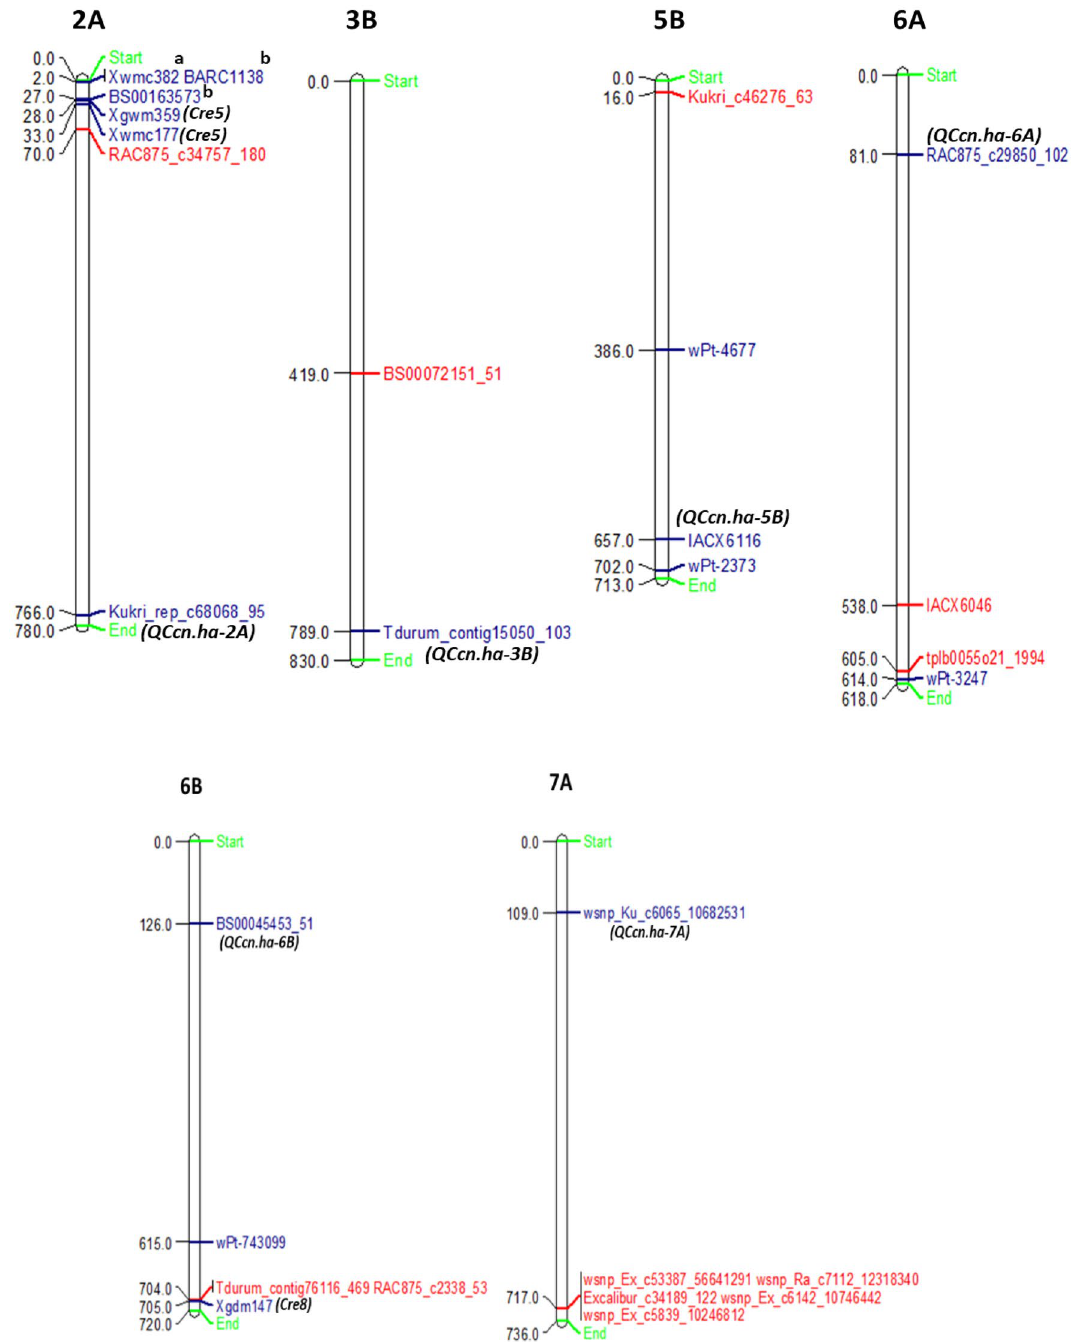
Figure 6. Chromosome maps showing MTAs detected in the present study and genes/QTLs/MTAs of H. avenae reported in the previous studies. The MTAs detected in the present study are depicted in red font. Markers associated with previously reported genes/QTLs/MTAs for H. avenae are shown in blue coloured font. The designated genes/QTLs associated with the markers are shown in black coloured font. Superscript a: represents the QTL, QCre.pau-2A linked to marker Xwmc382 and superscript b: represents the QTL, QCre- ma2A linked to marker BARC1138 and BS00163573 such as ACD6 and BDA1 are positive regulators of salicylic acid (SA) signaling in defense responses 68–70 . Brown plant hopper-resistance gene BPH14 , a CC-NB-LRR (CNL) gene has been found to confer resistance to brown plant hopper (BPH) and white-backed plant hopper (WBPH) 71 . Its structural and functional analysis indicates that the CC and NB (nucleotide binding) domains confer BPH resistance and activate SA signaling pathways. A putative RING/FYVE/PHD-type zinc finger gene is engaged in programmed cell death and also shows a resist- ant response against pests 72 . Receptor serine-threonine kinases (RSTK) generally interact with different other